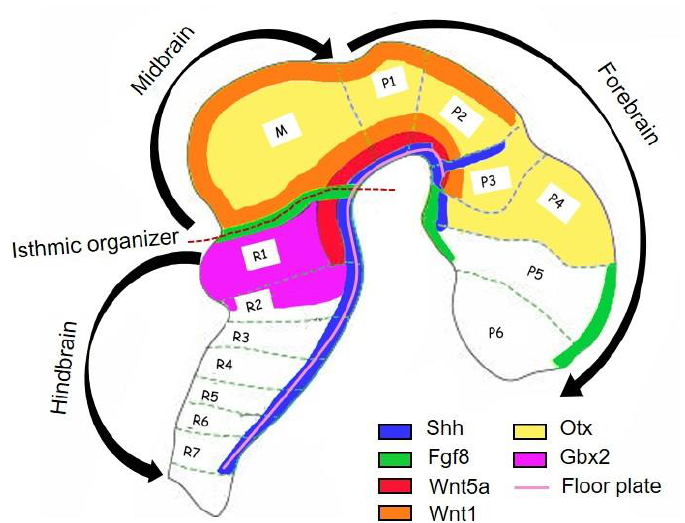
Figure 2. Schematic representation of signaling and morphogen involved in the formation of DA neurons. Otx and Gbx2 are two transcription factors acting antagonistically to set up the position of the IsO, that defines the midbrain–hindbrain boundary. IsO produces Fgf8, that together with Shh defines the region of midbrain DAminergic neurons development. Wnt1 and Wnt5 are expressed in this region and essential for the formation of midbrain (M). Prosomeres, P1 – P6; Rhombmeres R1-R7.